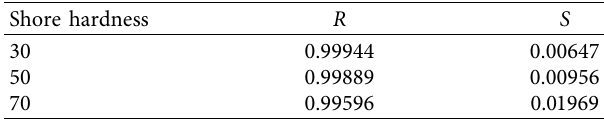
Table 4: Correlation coefficient and standard deviation of the fingertip force